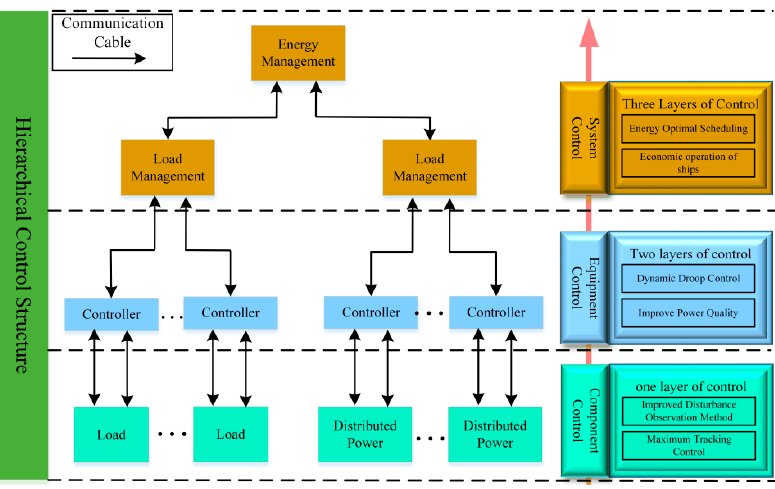
Figure 12. Design diagram of the hierarchical control scheme.